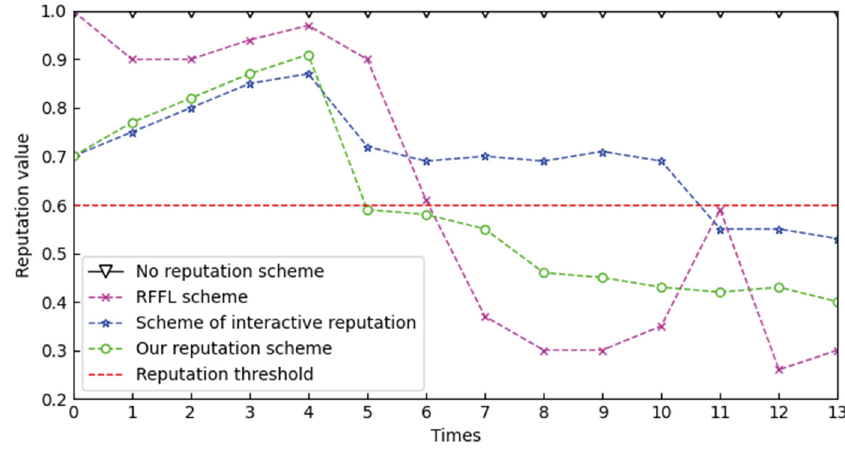
Figure 11. Scheme comparison of reputation value change.